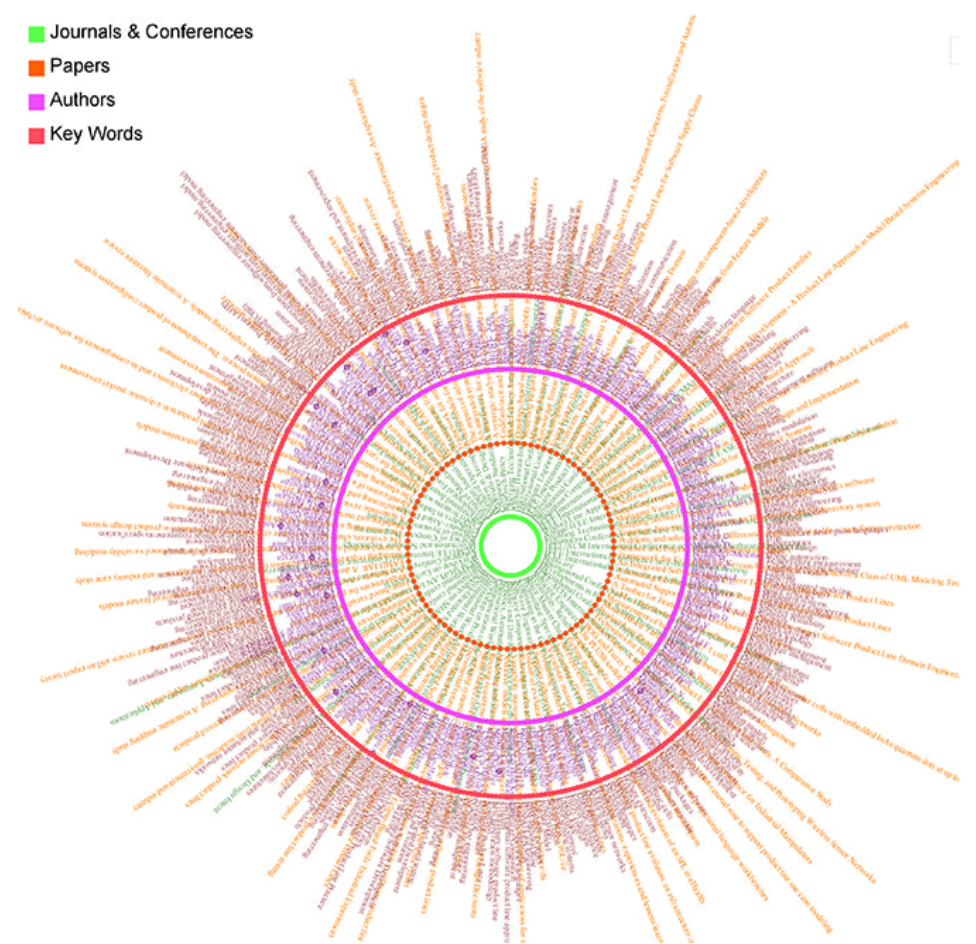
Figure 5. Overview view without any actions as a first view. The tool is available online: https: //roozbehh.github.io/DependencyNestedRing_Visualization/ (accessed on 22 April